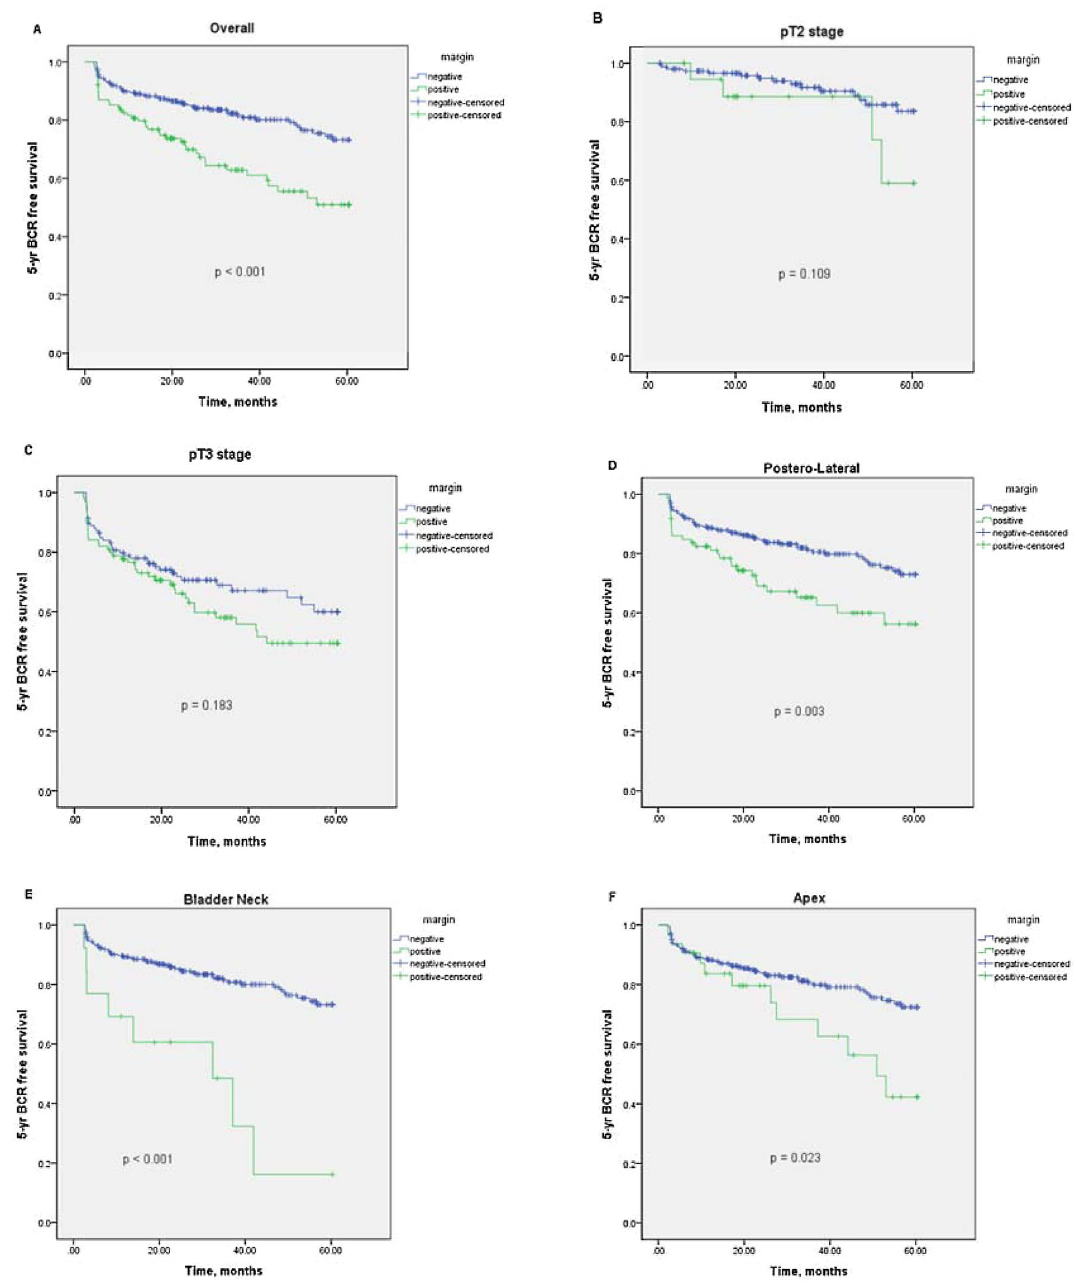
Figure 1. Kaplan–Meier curve for 5-year biochemical recurrence (BCR)-free survival stratified by margin status. ( A ) stratified by positive and negative surgical margins ( p < 0.001); ( B ) and ( C ) stratified by pT2 and pT3 stage ( p = 0.109 and p = 0.183); (D )–( F ) stratified by positive surgical margins in posterolateral, bladder neck and apex ( p = 0.003, p < 0.001 and p =